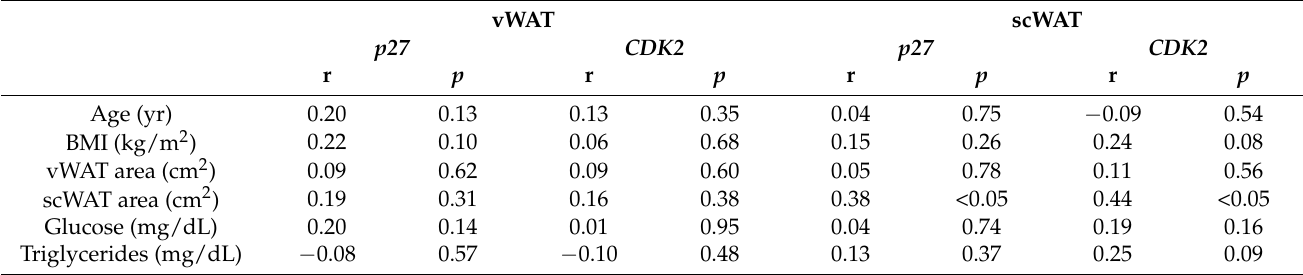
Table 3. Correlation analyses of p27 and CDK2 mRNA expression in human vWAT and scWAT with age, BMI, vWAT and scWAT area, serum glucose and